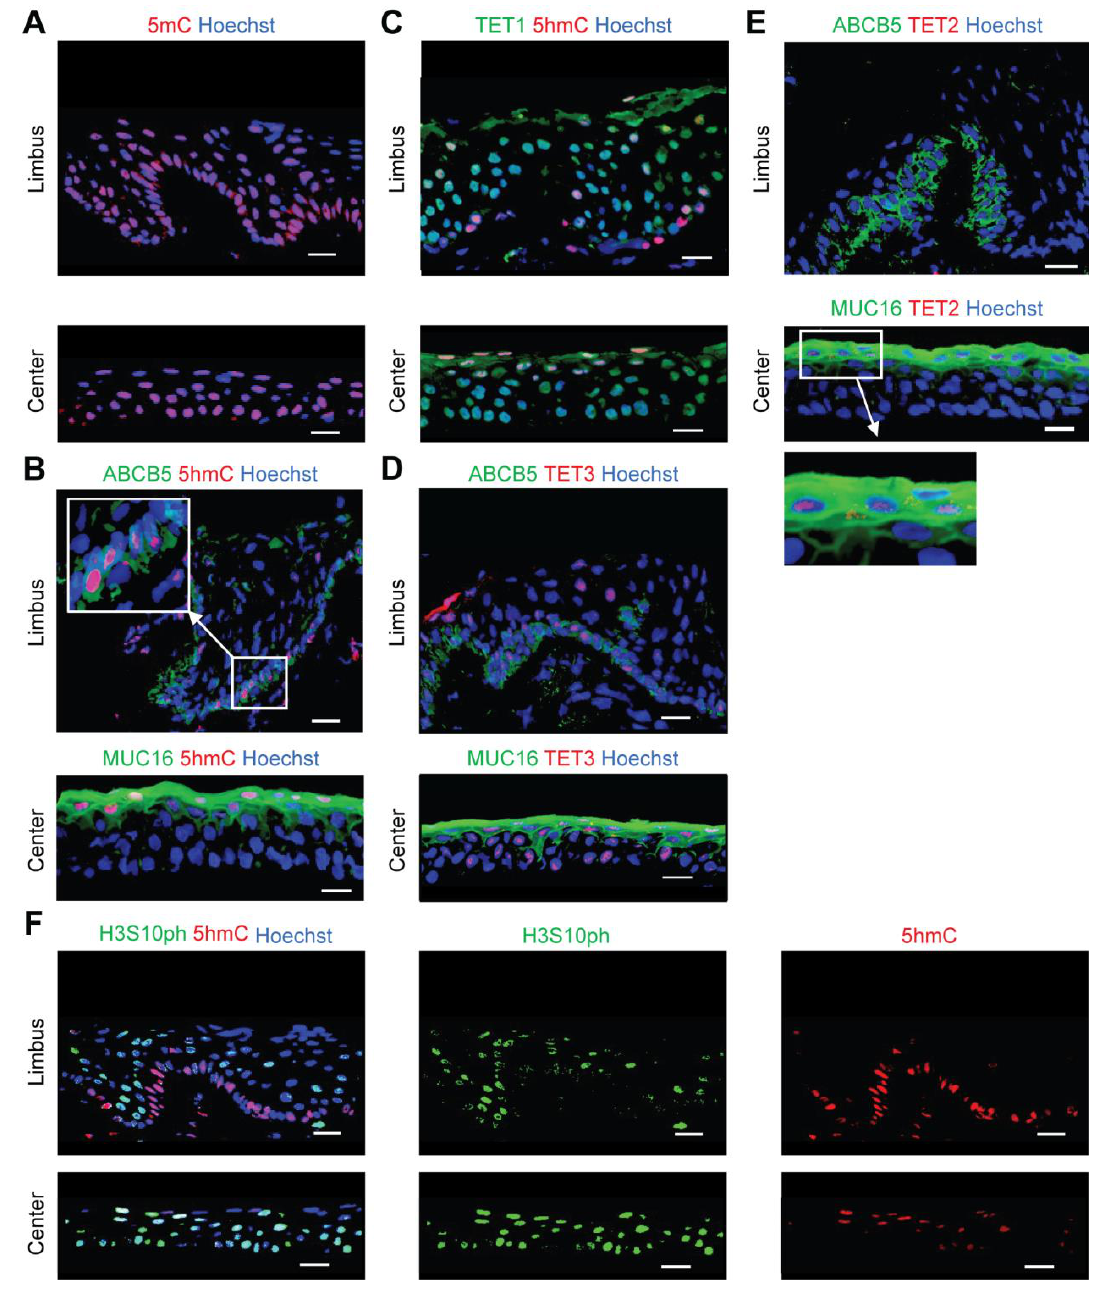
Figure 1. Characterization of 5mC and 5hmC expression in the human cornea. Representative immunostaining analyses of: ( A ) 5mC expression in the limbus (top) and central cornea (bottom), ( B ) ABCB5 and 5hmC co-expression in the limbus (top), and MUC16 and 5hmC co-expression in the central cornea (bottom), ( C ) TET1 and 5hmC co-staining in the limbus (top) and central cornea (bottom), ( D ) Co-expression of ABCB5 and TET3 in the limbus (top), and co-staining of MUC16 and TET3 in the central cornea (bottom), ( E ) ABCB5 and TET2 co-staining in the limbus (top), and MUC16 and TET2 co-expression in the central cornea (bottom), ( F ) Co-staining of H3S10ph and 5hmC in the limbus (top) and the central cornea (bottom). Nuclei stained with Hoechst 33342 (blue), n = 3. Scale bar, 20 µm.